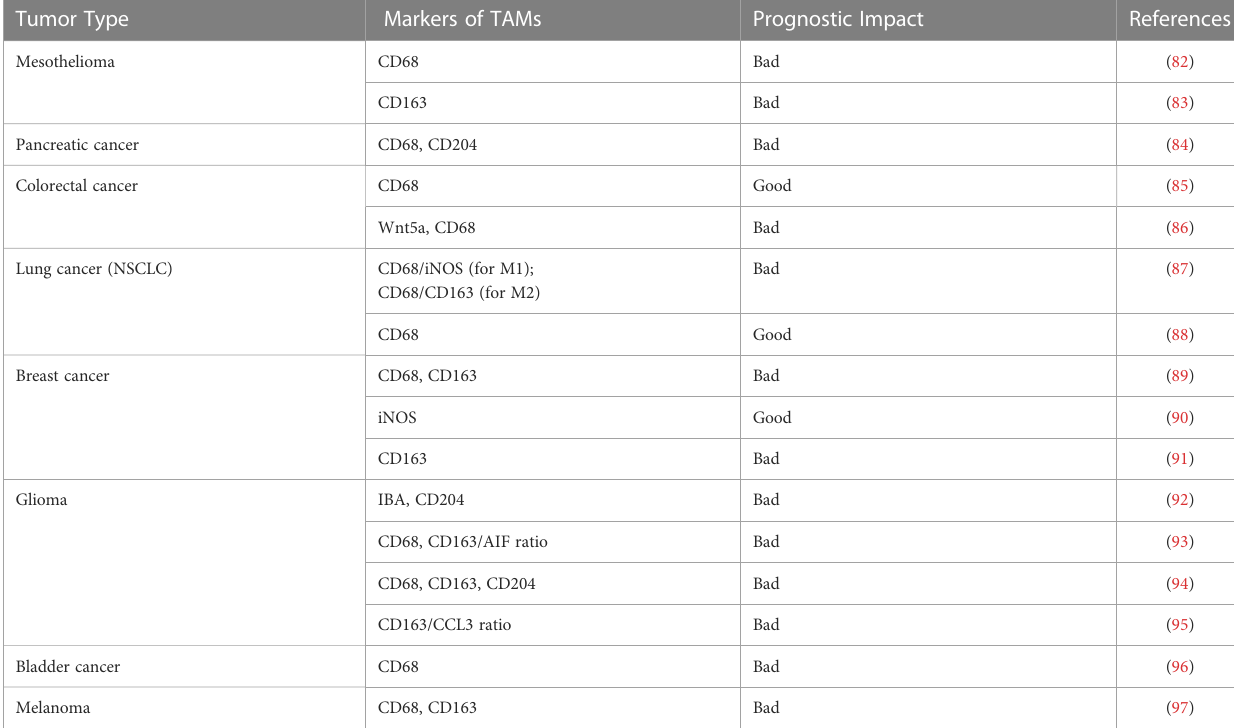
TABLE 1 TAM and marker prognosis in several human different